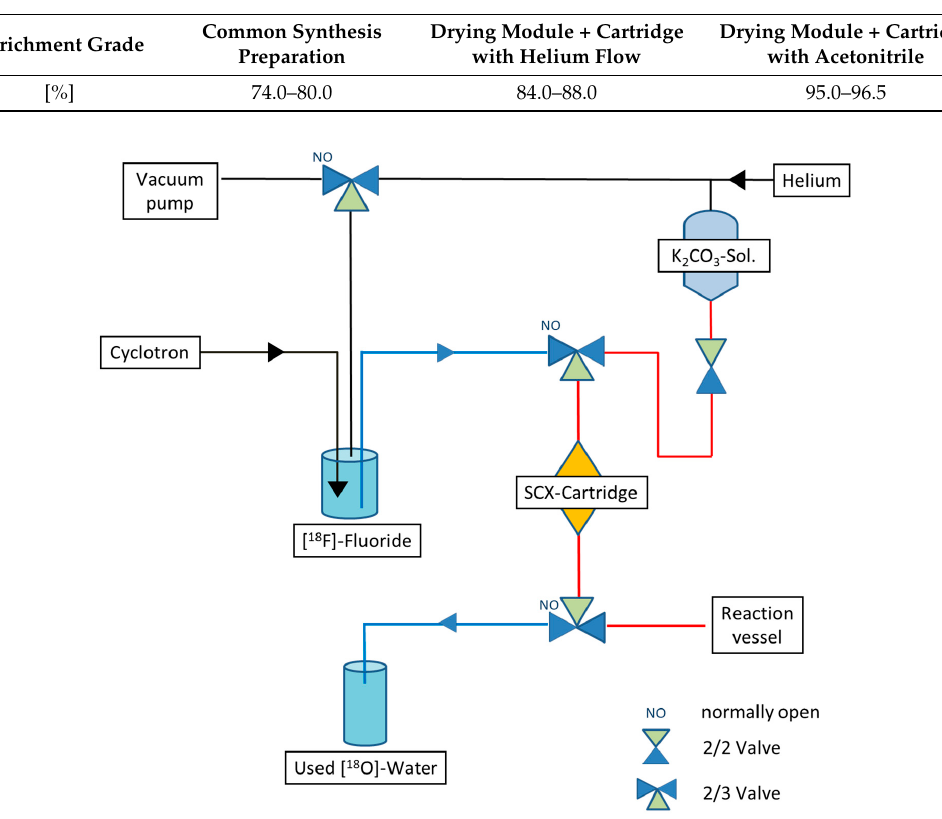
Figure 2. Schematic partial representation of the tubing system.